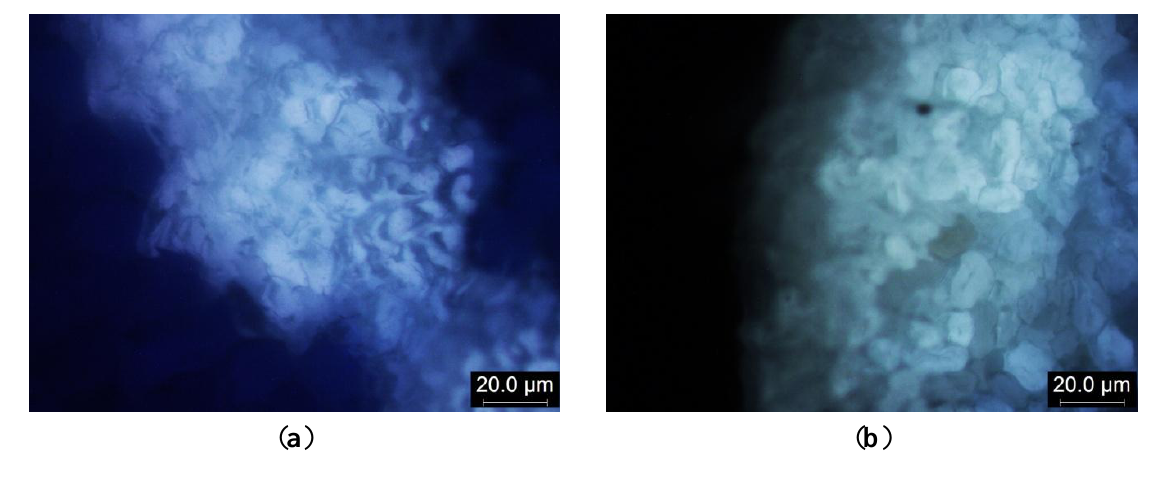
Figure 3. Fibre cross-sectional view of ( a ) Coolmax; and ( b )